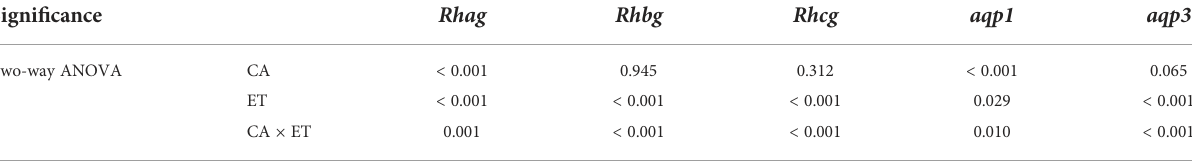
TABLE 2 Two-way ANOVA P value in a carbonate alkalinity exposure trial. Signi fi